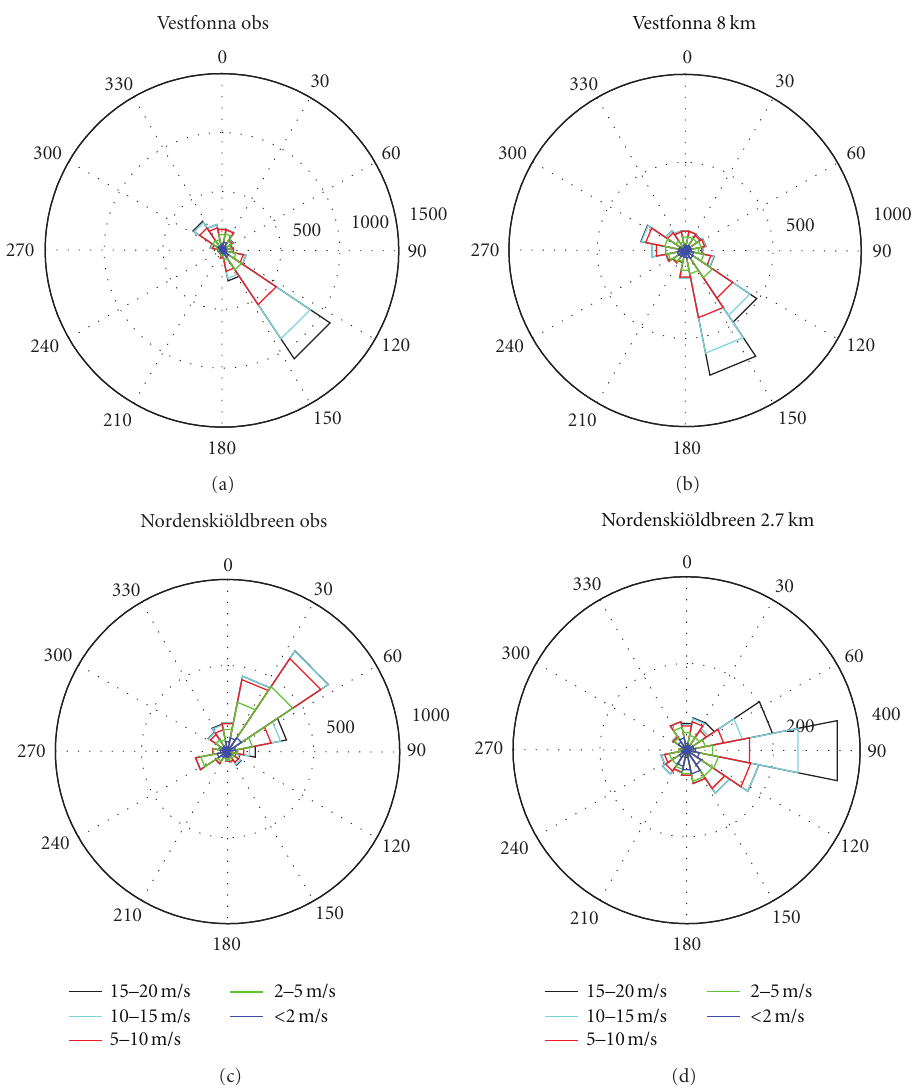
Figure 4: Wind roses of observed and simulated wind at Vestfonna and Nordenski¨oldbreen. Note that given frequency is absolute (hours).